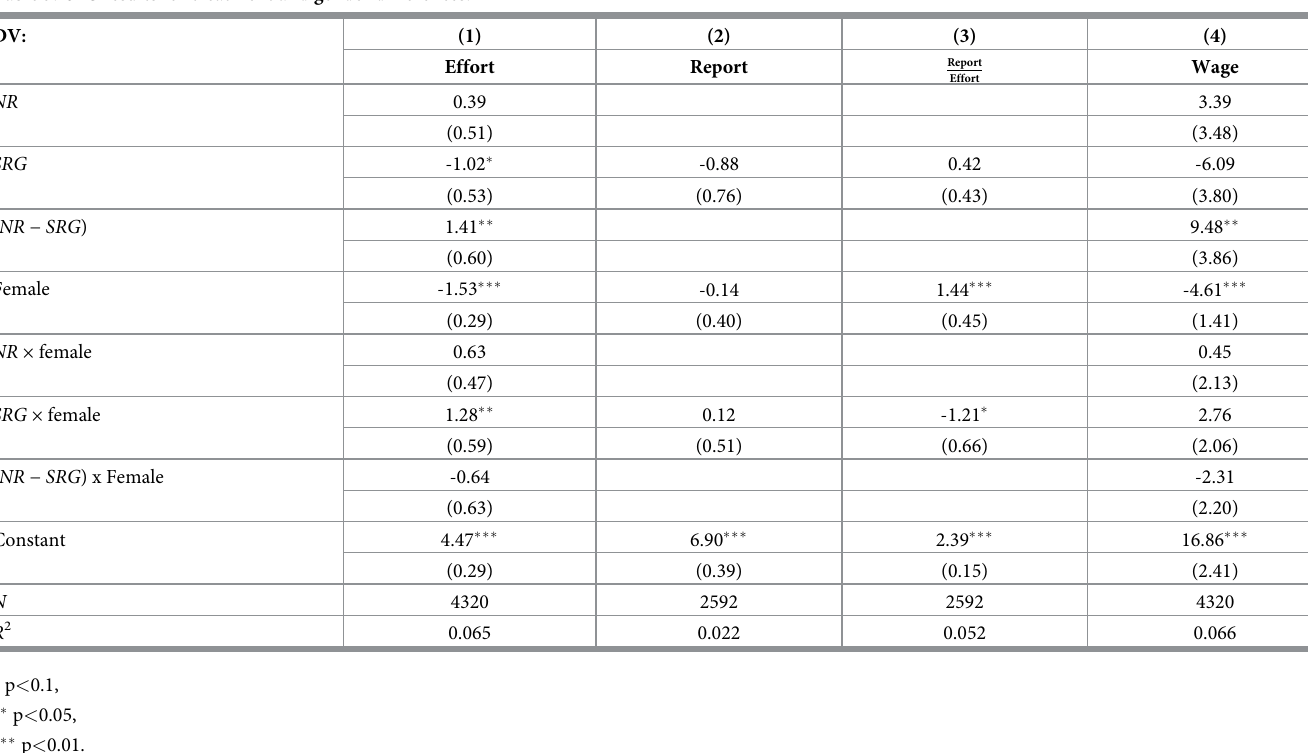
Table 3. OLS results for treatment and gender differences.